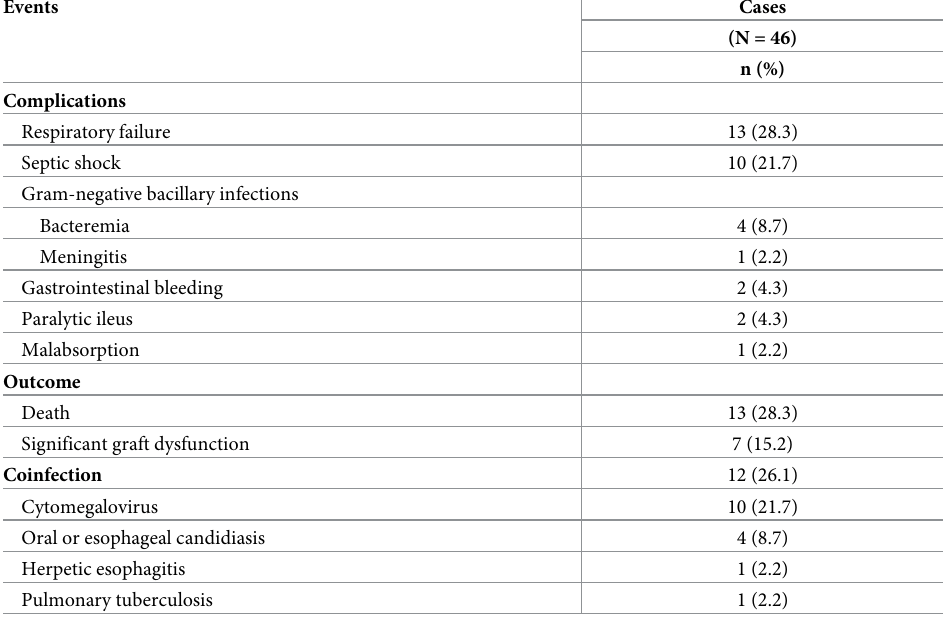
Table 3. Complications and clinical outcomes of severe Strongyloides stercoralis infection in kidney transplant